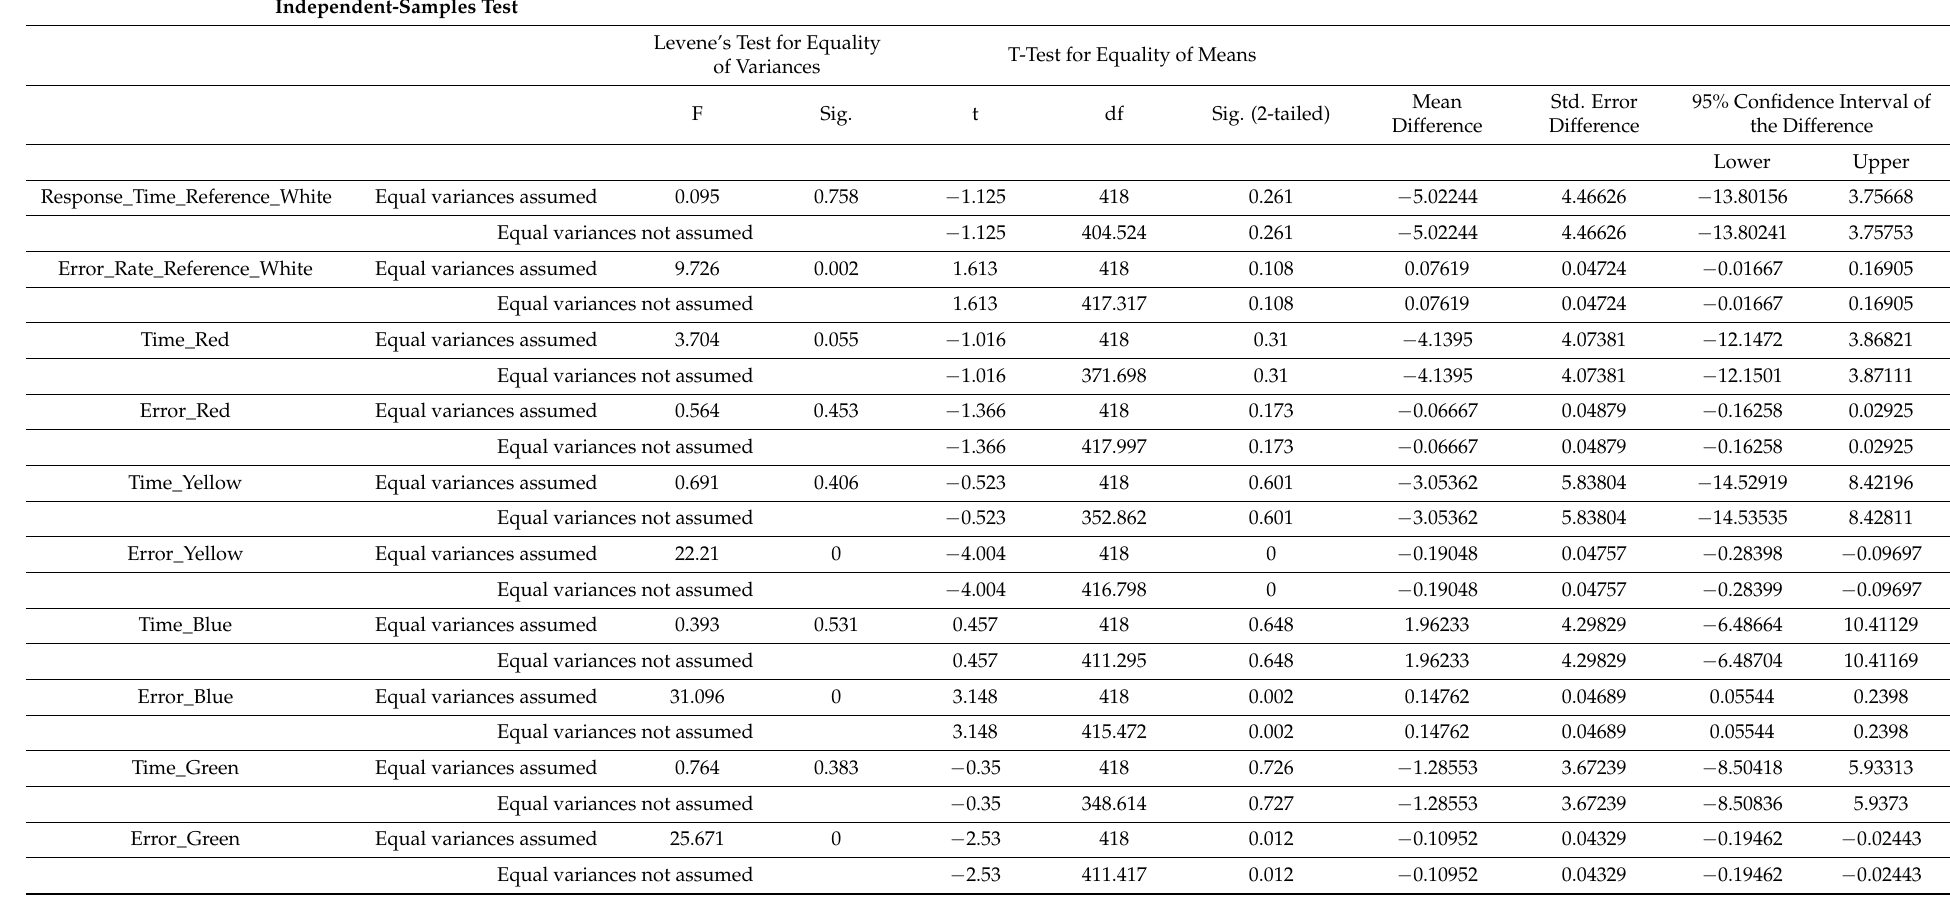
Table A19. The independent t -test analysis of people’s cognitive performance between PE and VR. Independent-Samples